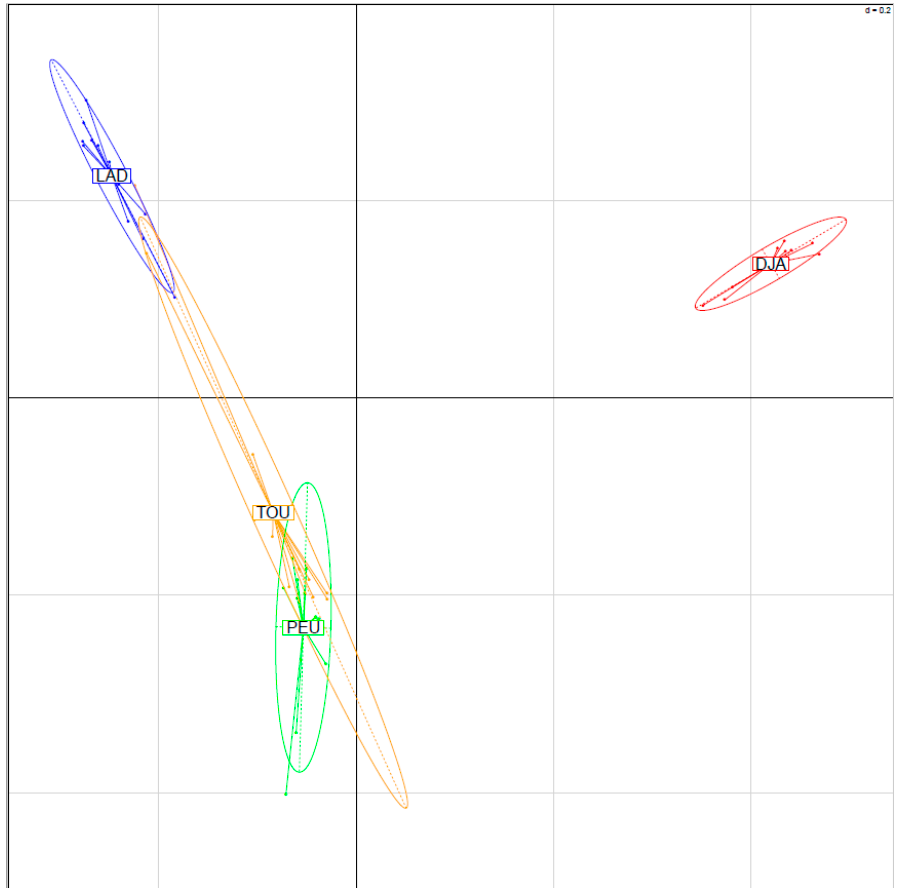
Figure 1. PCA results obtained with the 47 individuals of the four Senegalese breeds genotyped for 44,321 SNPs (SEN-Set). Individuals are plotted according to their coordinates on the first two principal components. Ellipses characterise the dispersion of each breed around its centre of gravity. The Admixture analysis (Figure 2) provided additional evidence of the distinctness of the Djallonke sheep that clustered in a separate group at k = 2. At k = 3, the clear contribution of the Touabire breed to the other trypanosusceptible breeds (i.e., Ladoum and Peul-peul) was illustrated and was consistent with the results of the principal component analysis.